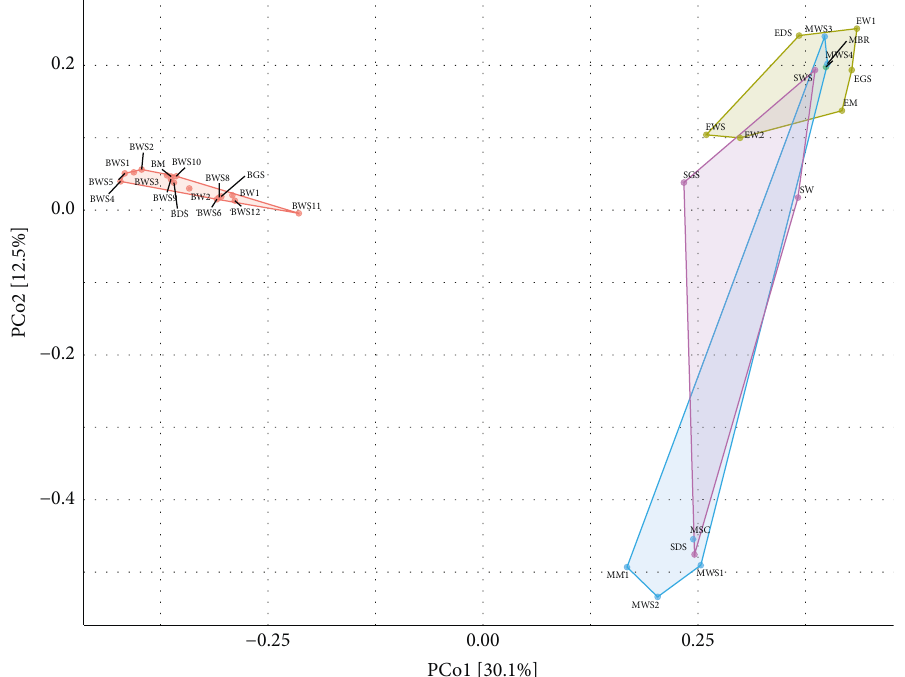
Figure 4: Bray–Curtis dissimilarity analysis showing the clustering of the